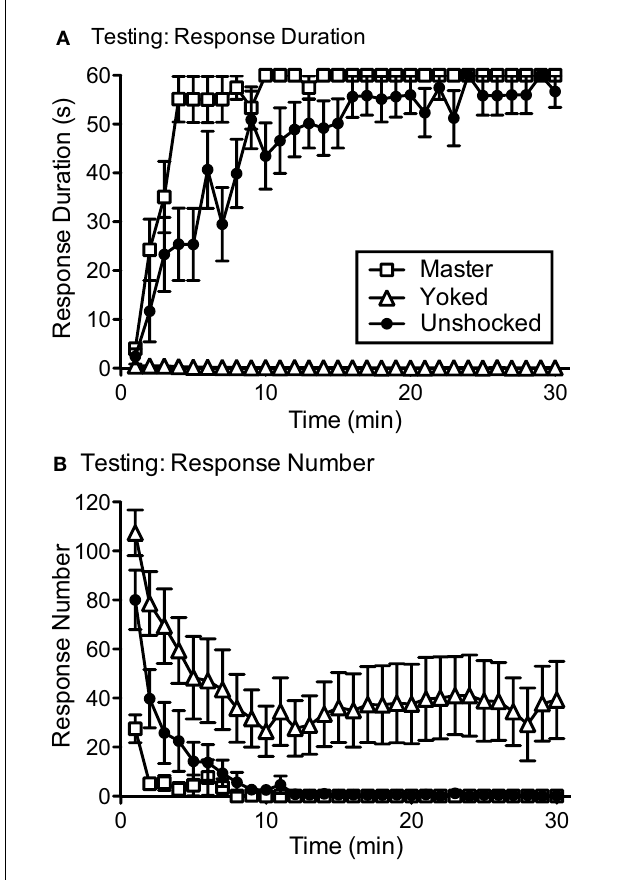
FIGURE 3 |Testing under common conditions. (A) Subjects that had previously received training with controllable shock (Master), uncontrollable shock (Yoked), or nothing (Unshocked), were tested for 30min with response-contingent leg-shock. Previously trained rats (Master) exhibited a savings effect that facilitated learning relative to the Unshocked controls. Subjects that had previously received uncontrollable shock (Yoked) did not exhibit an increase in flexion duration (our index of learning) when tested with controllable shock. (B) This learning deficit was not due to a failure to respond.Yoked rats exhibited the highest rate of responding and, as a result, repeatedly experienced the response-outcome ( R - O ) relation. Adapted from Grau et al.